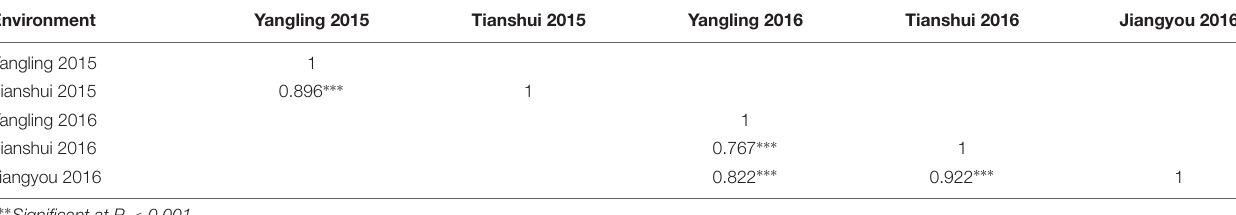
TABLE 1 | The correlation analysis of the mean maximum disease severity (MDS) for F 2 : 3 lines across two environment and relative area under the disease progress curve (rAUDPC) for F 6 recombinant inbred line population across three environment. Environment